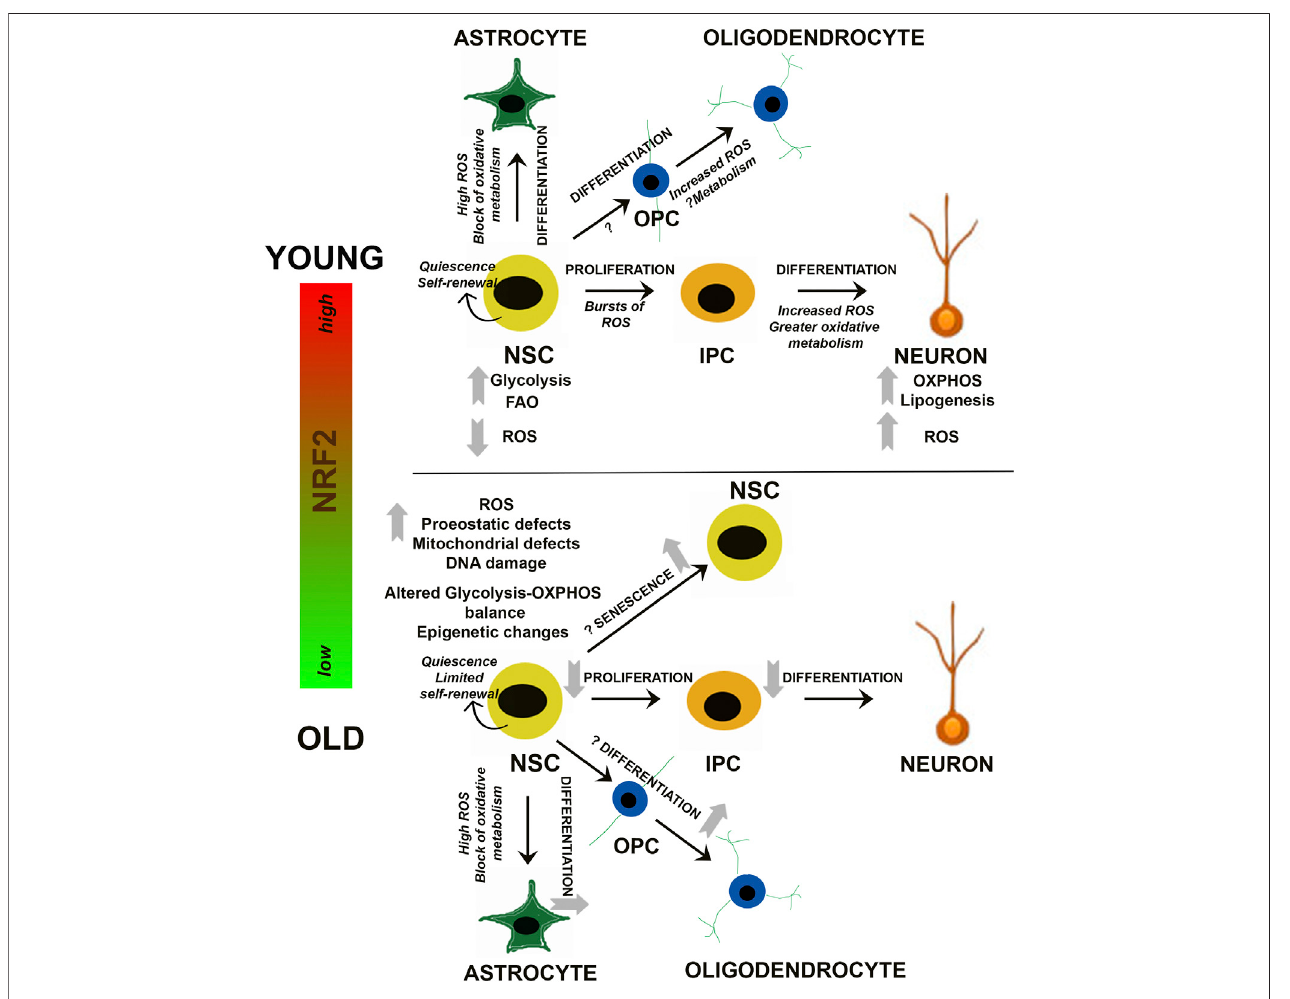
FIGURE 2 | Redox and Metabolic Regulation of NSCs. Schematic summarizing current fi ndings on how changes in NRF2-based ROS and metabolic processes may in fl uence the balance between NSC quiescence, self-renewal and differentiation. Alterations during NSC differentiation into neuronal and glial (astrocytes and oligodendrocytes) cells is depicted, and the questions marks indicate aspects which are yet unknown. IPC, Intermediate progenitor cell; OPC, Oligodendrocyte progenitor cell.